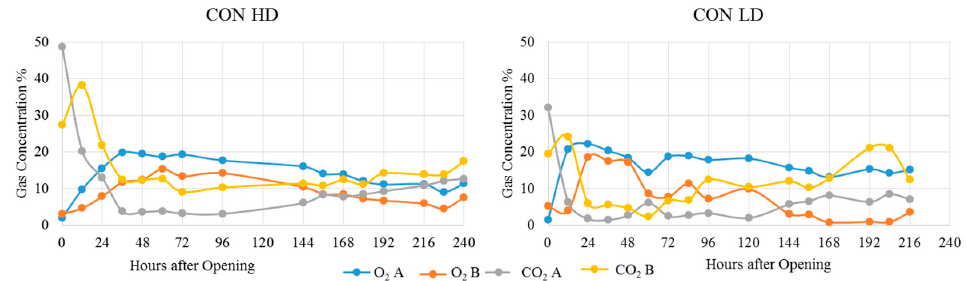
Figure 3. Means of gas concentrations of samples taken from buckets of the control variation at two sampling points (A and B); CON = control group, HD = high density, LD = low density.